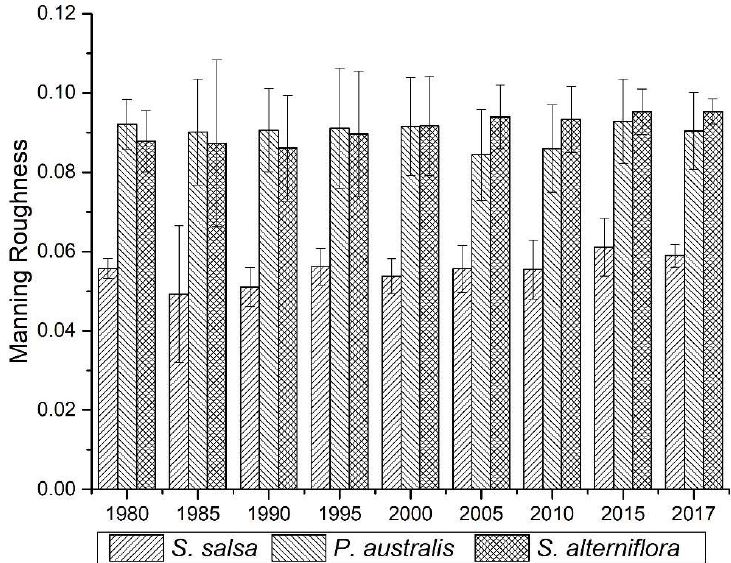
Figure 9. Manning roughness rate changes in different types of vegetation in coastal